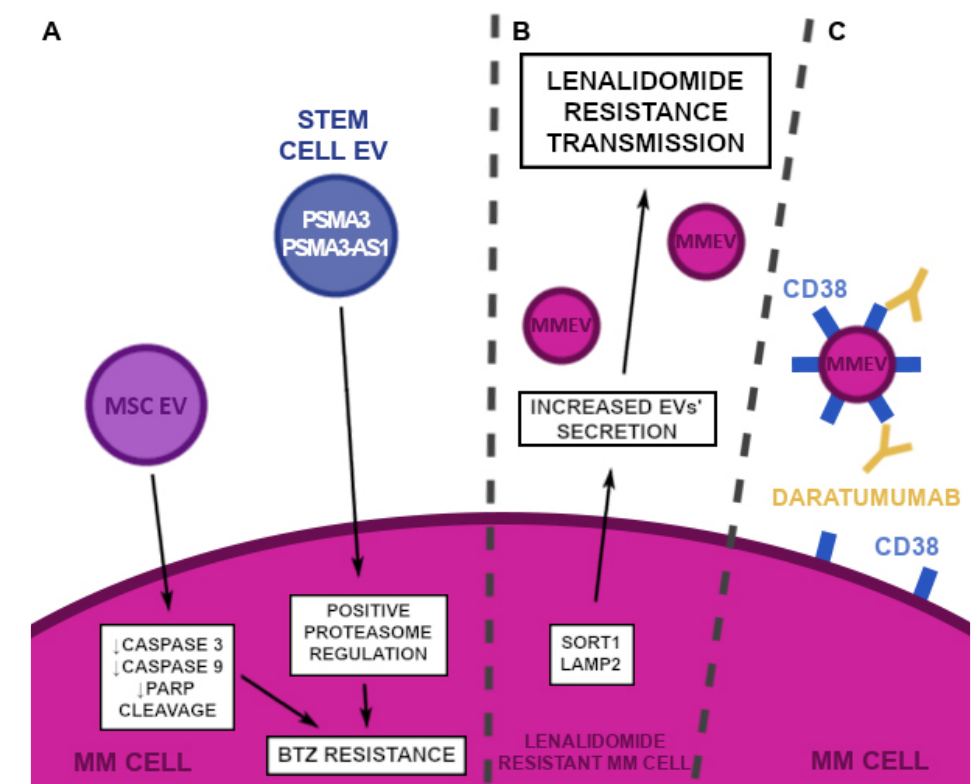
Figure 4. EVs’ involvement in the induction of drug resistance. ( A ) Bortezomib resistance is mediated by EVs in two ways. MM cells, stimulated by BMSC EVs show a decreased caspase 3, 9, and PARP cleavage, therefore the BTZ induction of the apoptosis is blocked. Moreover, stem cell-derived EVs, which contain PSMA3 and PSMA3-AS1, mediate the positive proteasome regulation, thus the apoptosis, due to an intercellular protein buildup of the damaged proteins is inhibited. ( B ) Increased expression of SORT1 and LAMP2 genes in lenalidomide-resistant MM cells lead to the increased release of EVs, which when up-taken by the lenalidomide-sensitive MM cell, confer the resistance. ( C ) EVs of MM cells express CD38 on their surface, therefore it appears that monoclonal antibodies may bind to EVs instead of MM cells, decreasing the bioavailability of the drug.